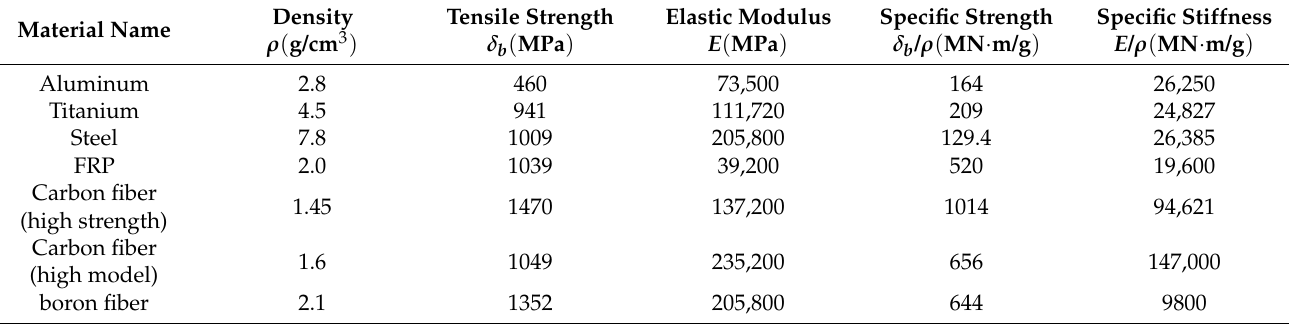
Table 1. Common material performance